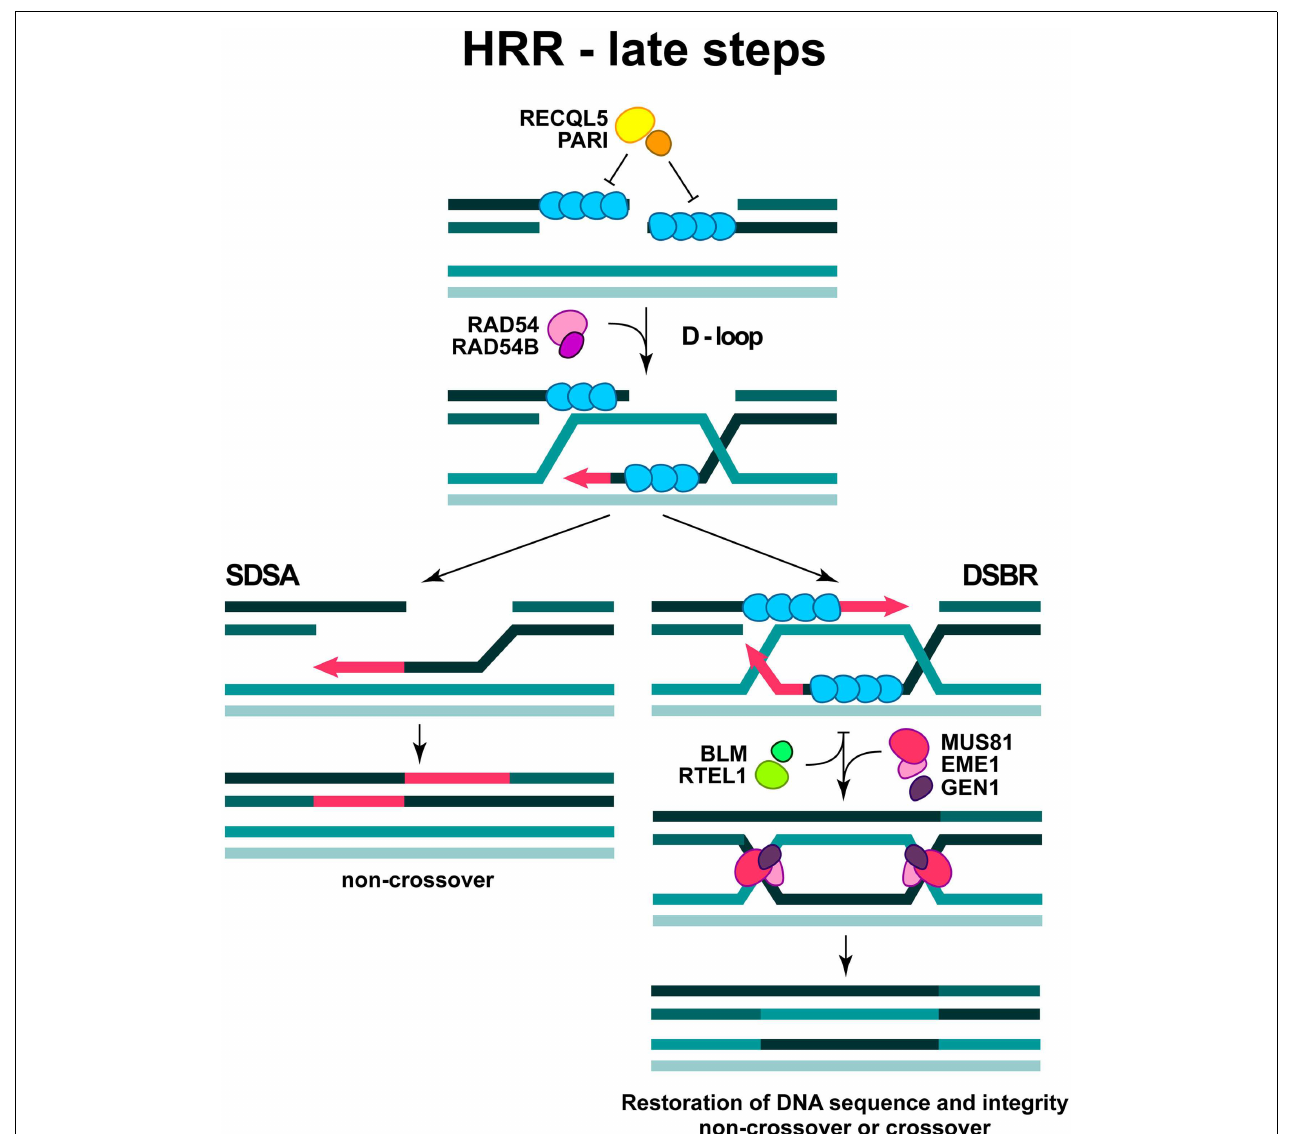
FIGURE 4 | Late steps in DSB repair by HRR .The formation of D-loop structure and two sub-pathways are depicted (see text for more